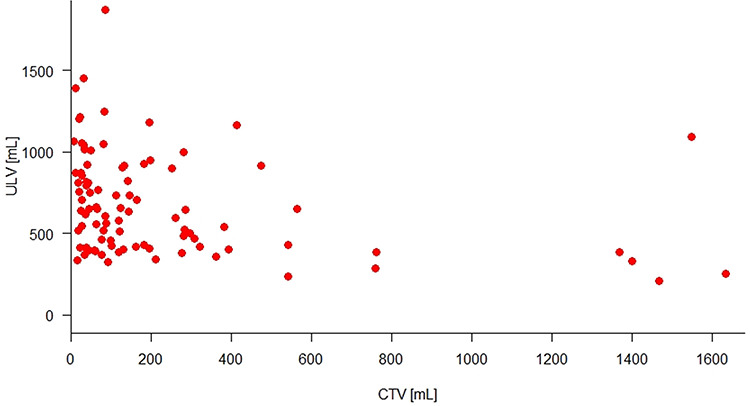
ULV tends to decrease corresponding to CTV increase.